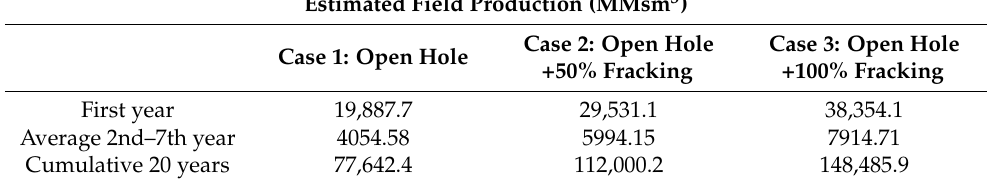
Table 5. Estimated field production data.